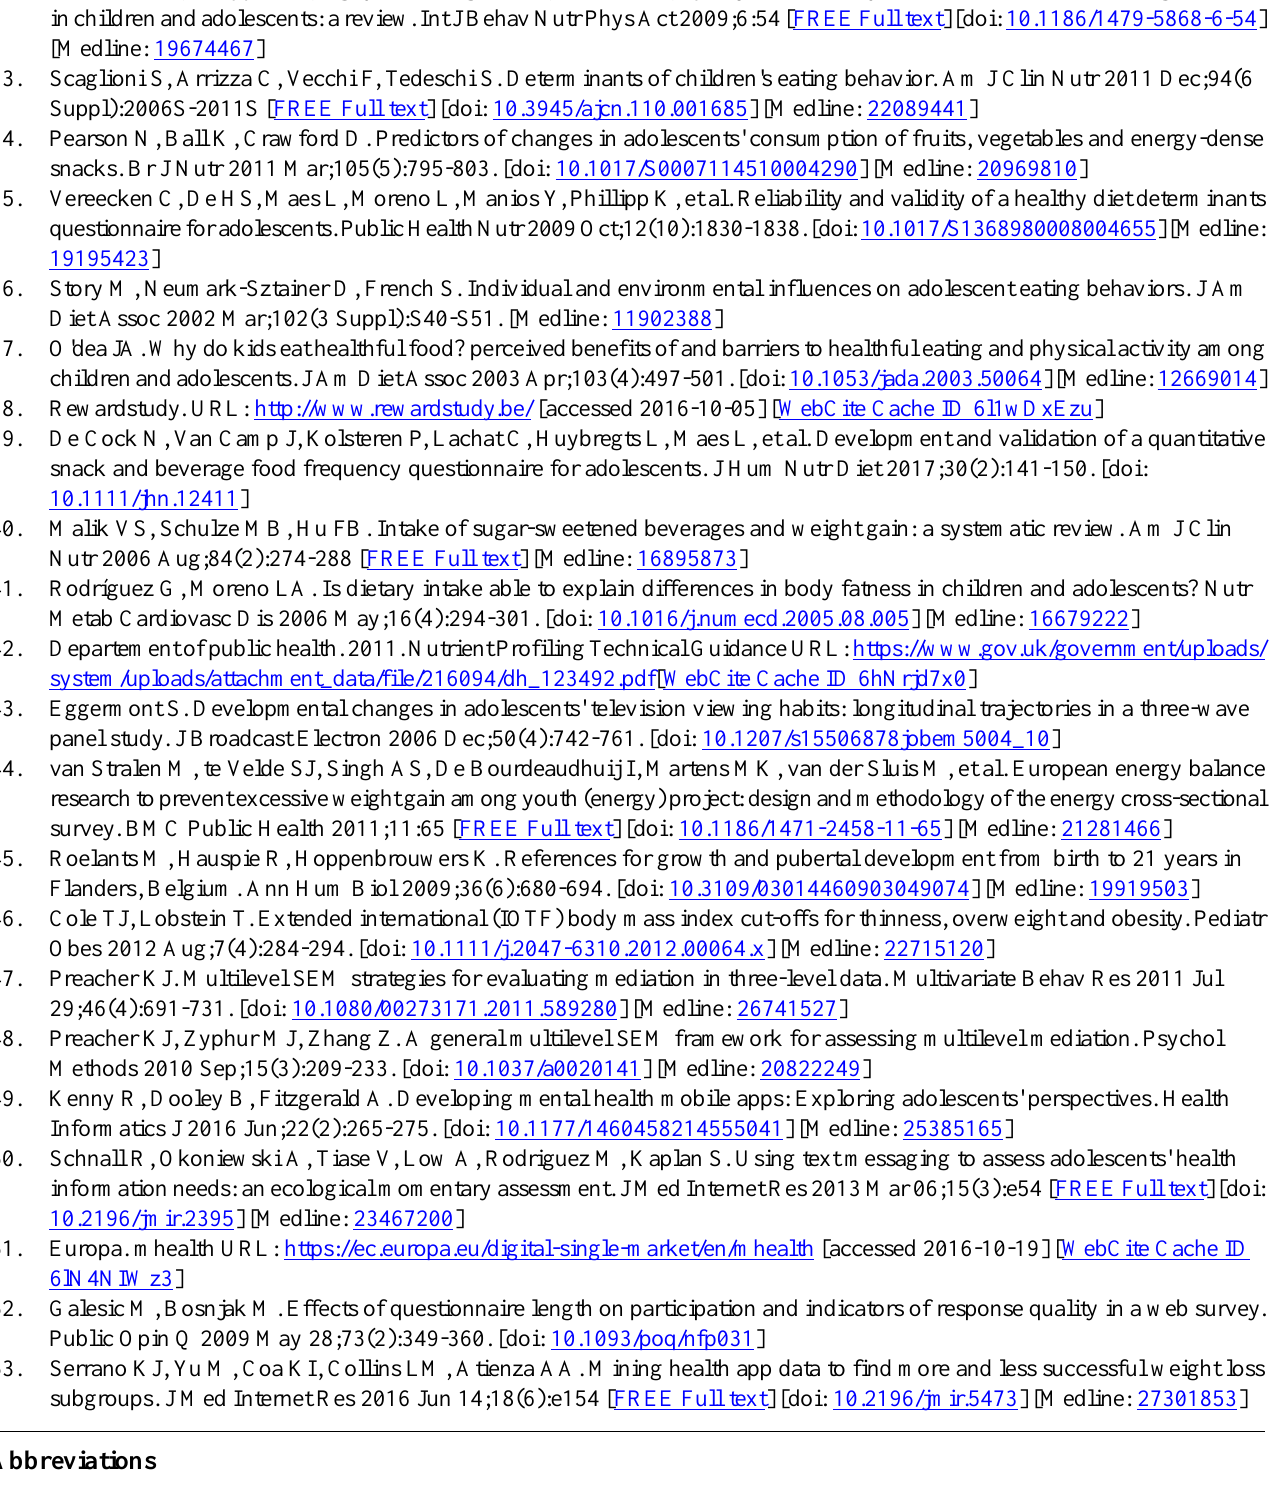
FFQ: food frequency questionnaire GSEM: generalized structural equation modeling MSEM: multilevel structural equation